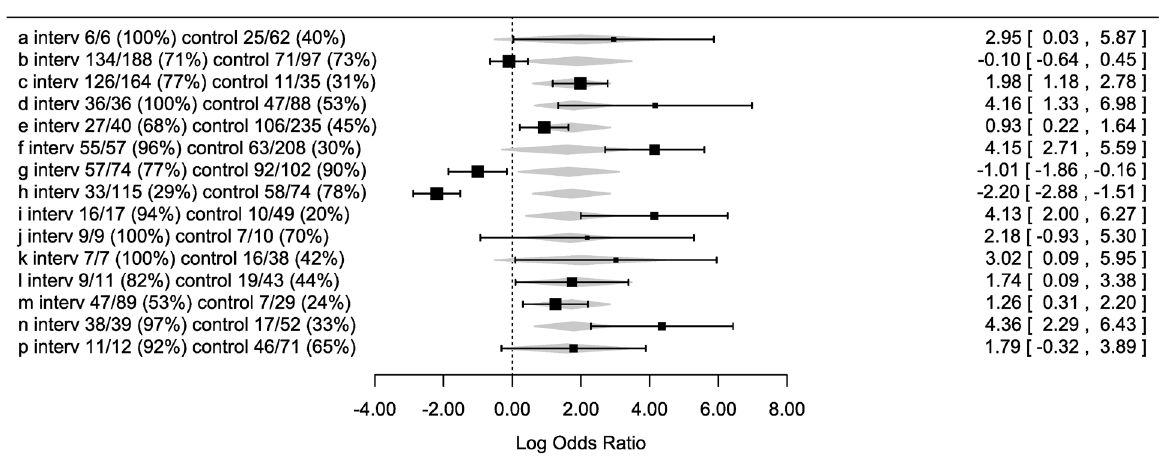
Fig 4. Forest plot of effect of intervention on each matched pair of clinicians, with correction for the (non-significant) differences in baseline performance(the percentage of patients with letters sent within 90 days of the visit) at the time of randomization. For each pair of doctors, we show the numberof letters sent before 90 days/ the total numberof letters which were due duringthe trial, and the resultingpercentage of letters sent on time. The log odds ratio and confidenceintervals are shown graphically (black bars = actual performance, grey diamonds = predicted performanceaccordingto the meta-analytic model), and numerically (in the right column).